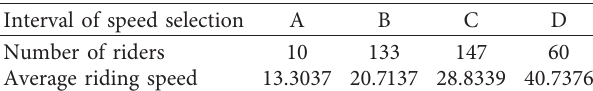
Table 4: Traveling speed of e-bike